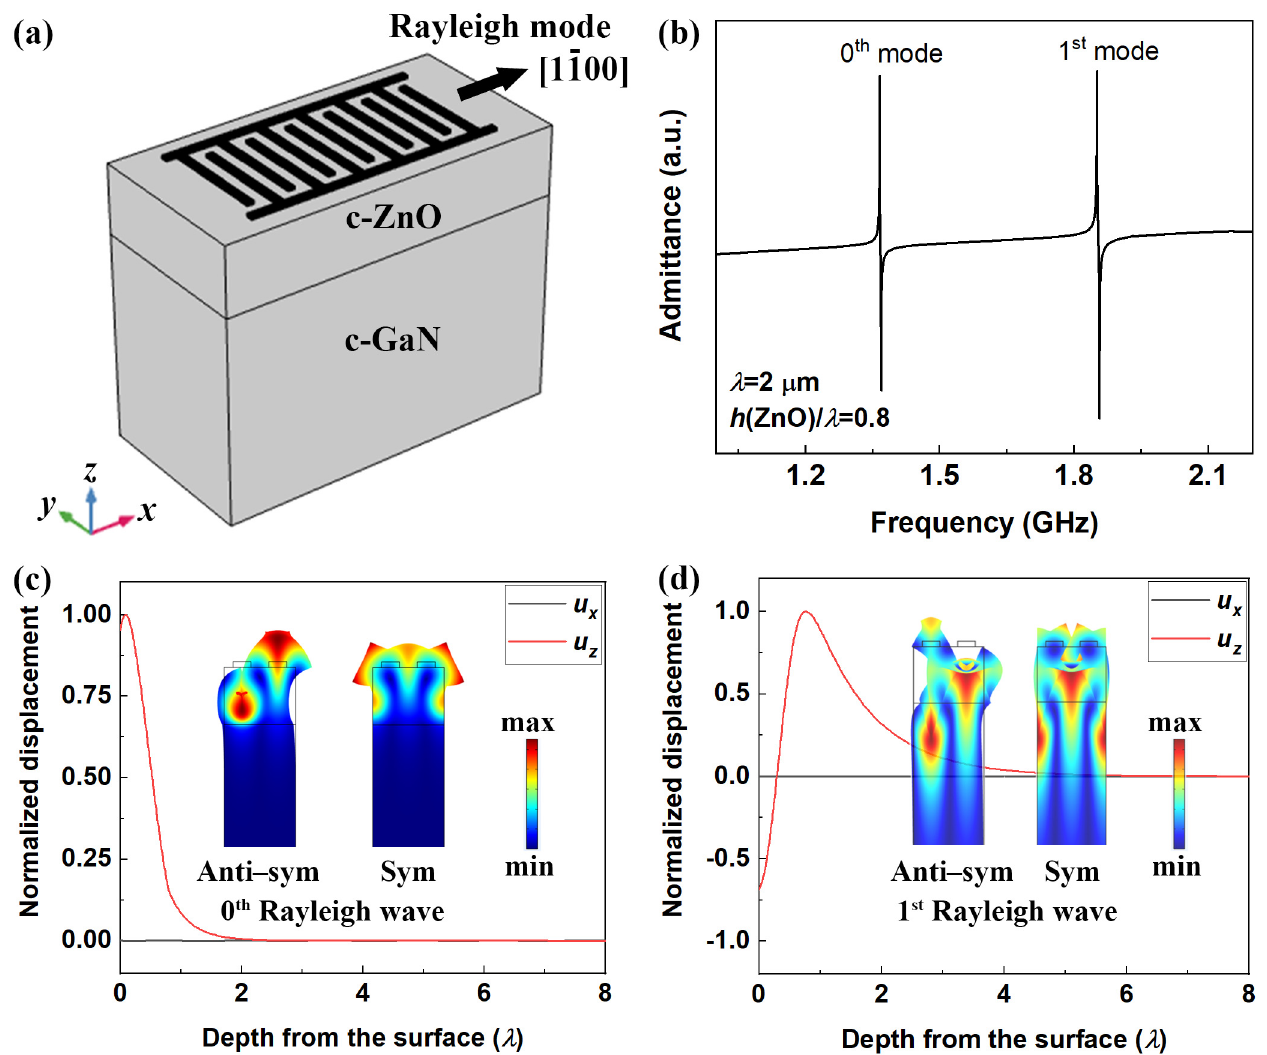
Figure 6. A typical admittance response ( b ) and its corresponding displacement curves and deformation shapes ( c , d ) of the SAW devices based on the c-ZnO/c-GaN structure ( a ) where Rayleigh-mode waves are excited.